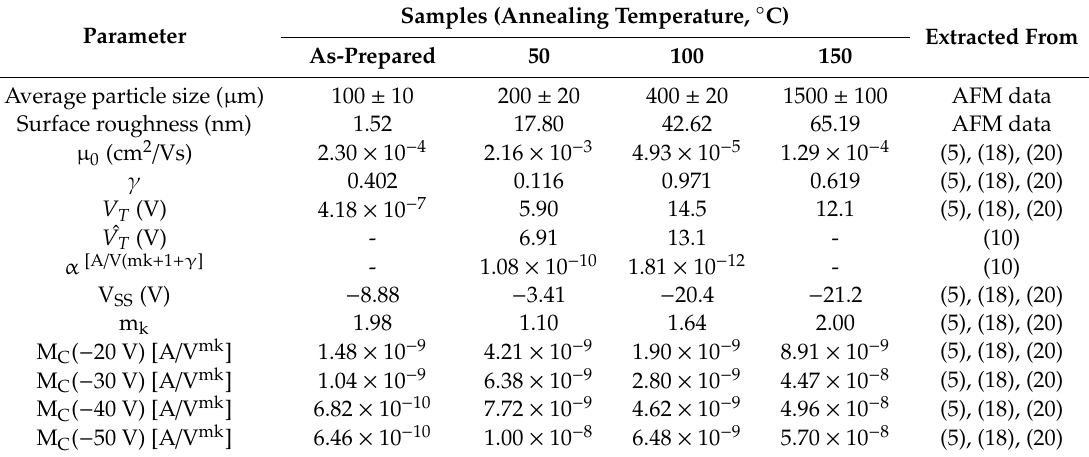
Figure 3. Two-dimensional AFM micrographs of the surfaces of the thin films of NiPc 6 : ( A ) as-prepared, prior to heat treatment; heat treatment during two hours at ( B ) 50 °C , ( C ) 100 °C and ( D ) 150 °C . Table 1. Parameters of the NiPc 6